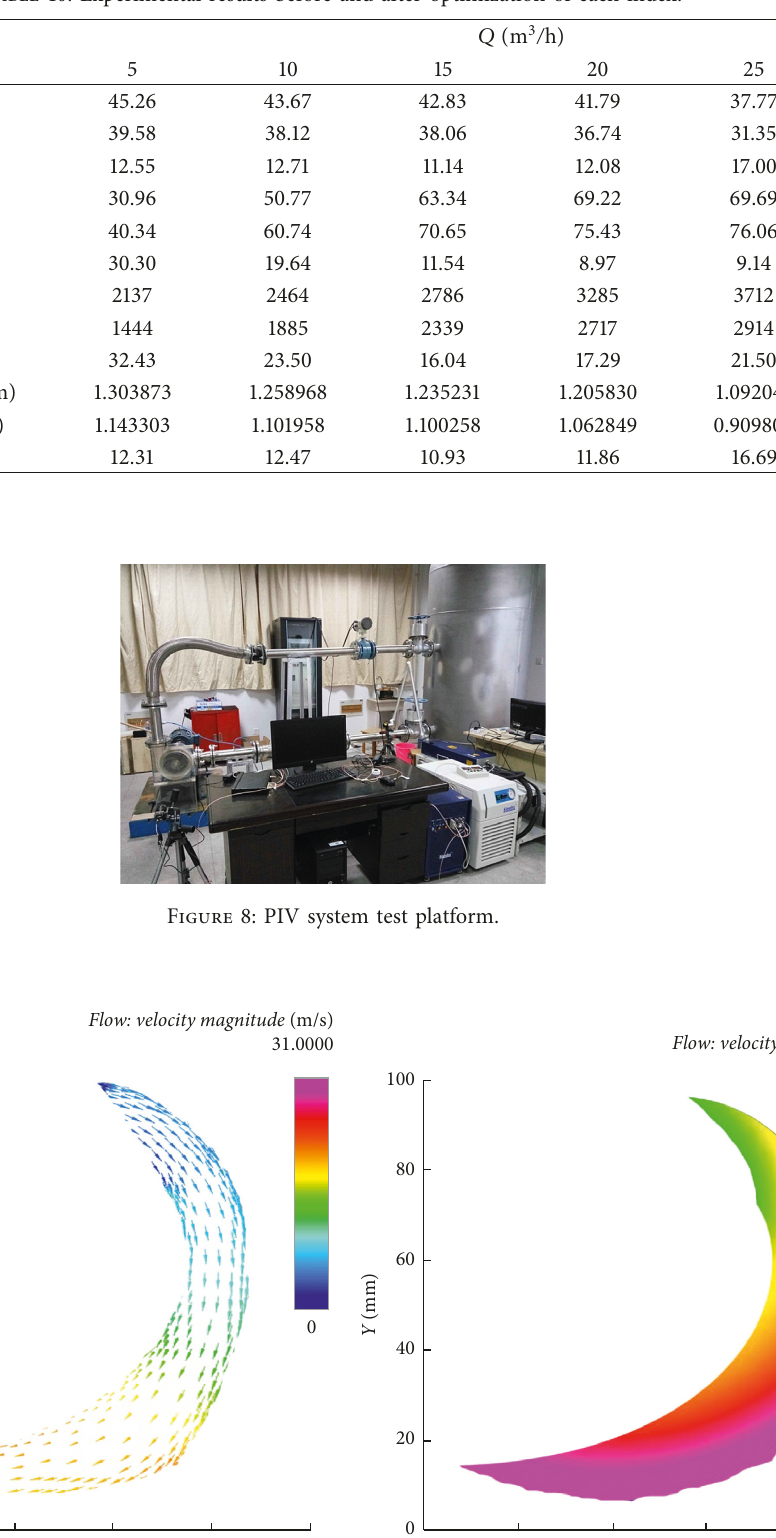
Table 10: Experimental results before and after optimization of each index.